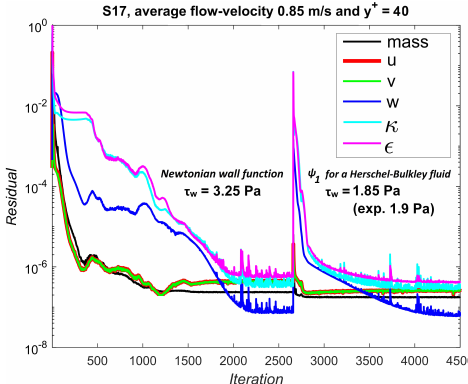
Figure 7. Normalised residuals for one of the test cases. Applying ψ 1 improved the numerical prediction of the wall shear